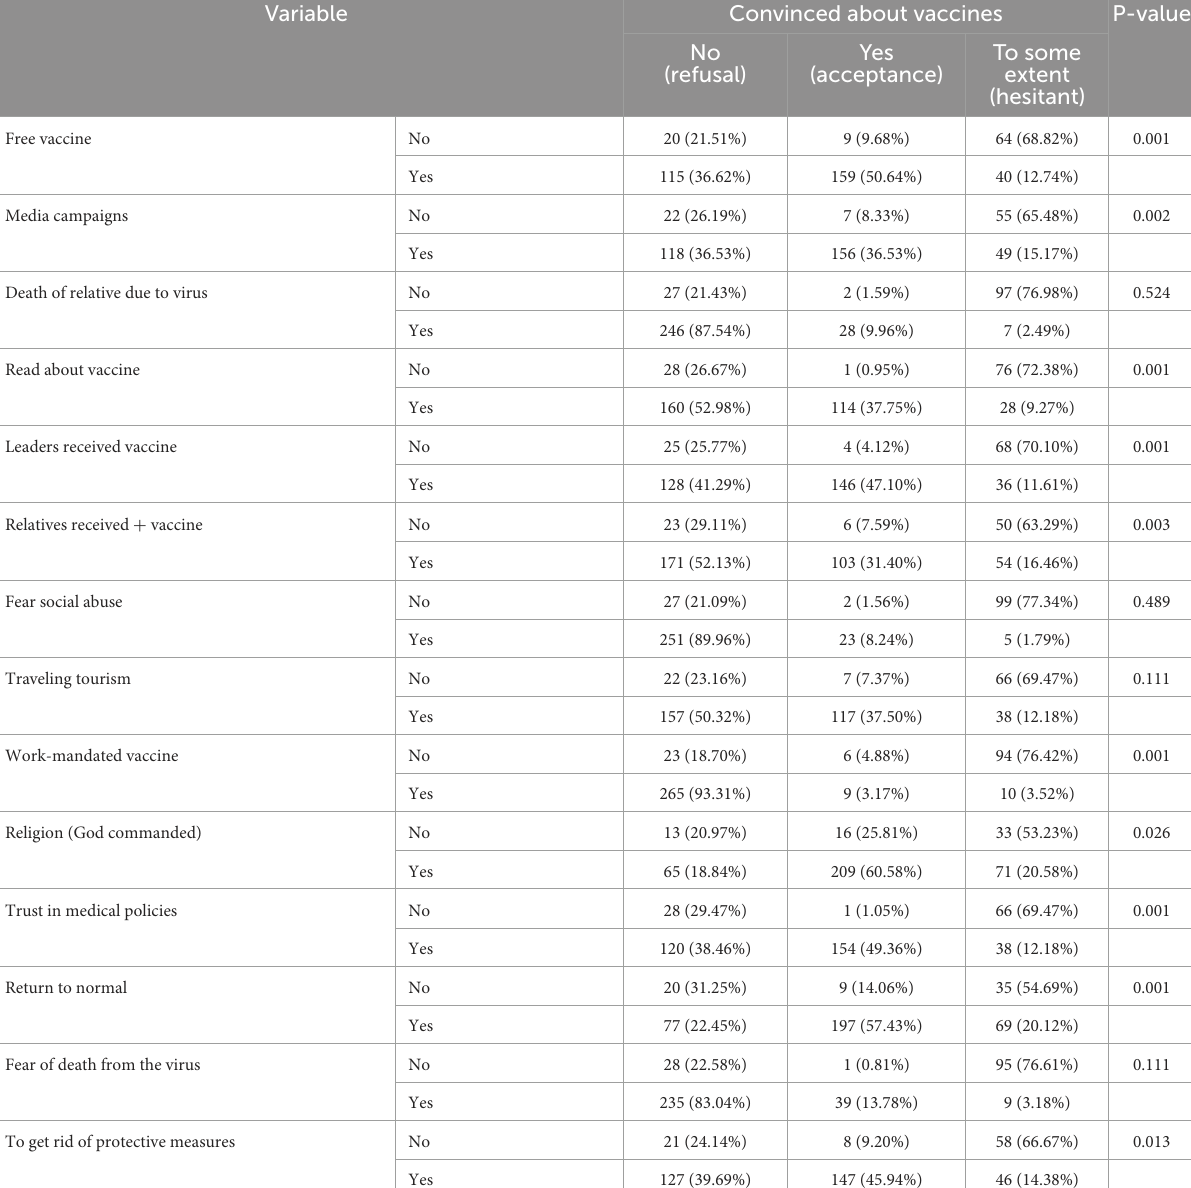
TABLE 4 The frequency distribution and chi-squared analysis of social and cultural motivations behind individual’s vaccine confidence. Variable Convinced about